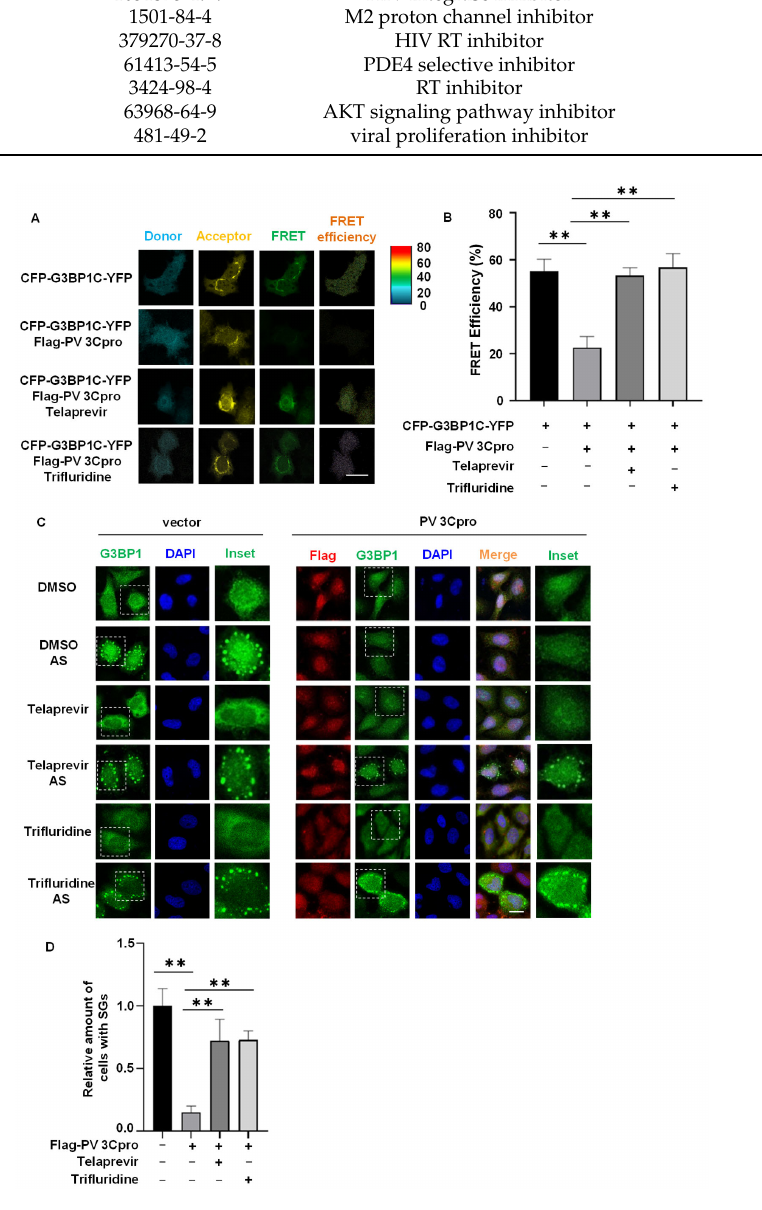
Figure 4. Identification of Telaprevir and Trifluridine as PV 3Cpro inhibitors by drug screening. ( A ) HeLa cells were transfected with CFP-G3BP1C-YFP together with Flag-PV 3Cpro or vectors, and were untreated or treated with 10 µ M Telaprevir or Trifluridine 5 h after transfection, followed by FRET using the FRET module of the Zeiss LSM880 confocal microscopy system. Scale bar: 20 µ